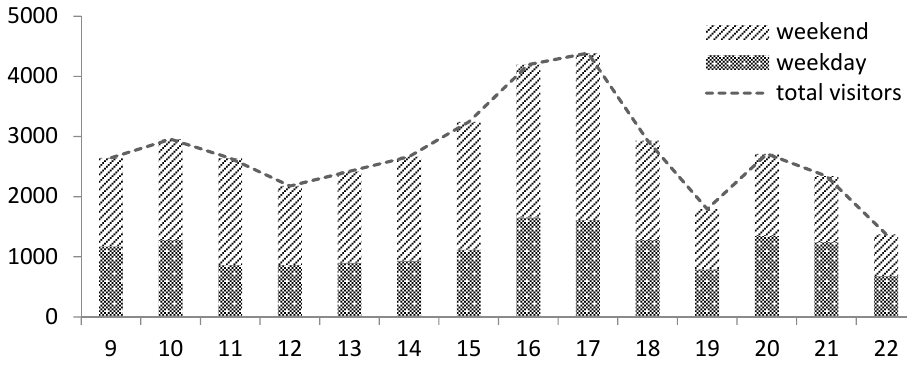
Figure 2. Total visitors observed in all open spaces by hours.